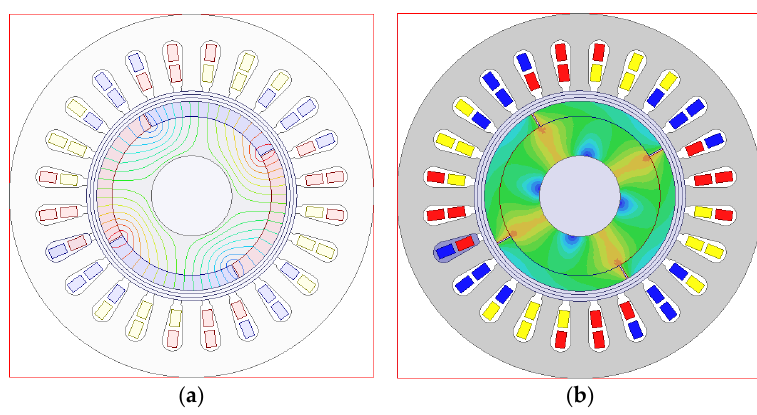
Figure 13. The electromagnetic field analysis of the prototype. ( a ) Flux lines; ( b ) The magnetic flux density distribution.